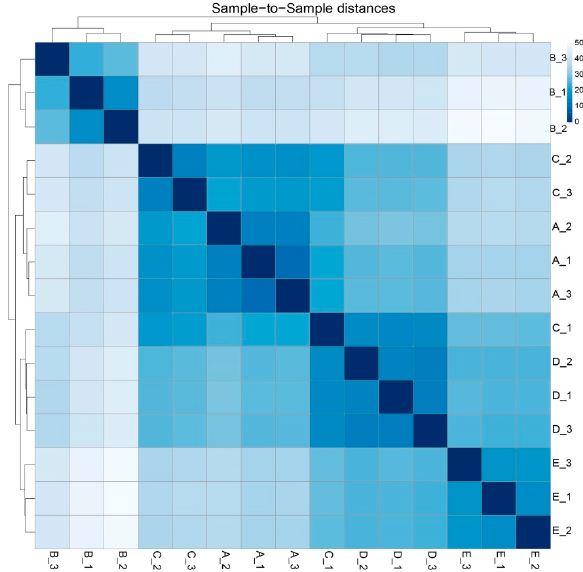
Figure 4. Gene expression analysis. Sample clustering of 5 growth stages. Sample correlation is based on their gene expression profile. The color scale represents the correlation coe ffi cient. The sample clustering was used to investigate the expression patterns of genes at 5 successive growth stages in C. fortunei vascular